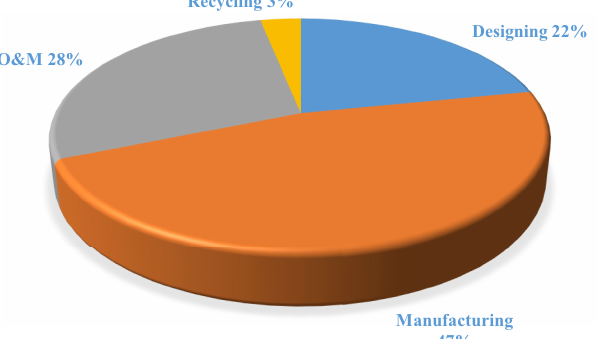
Figure 4. Proportion of